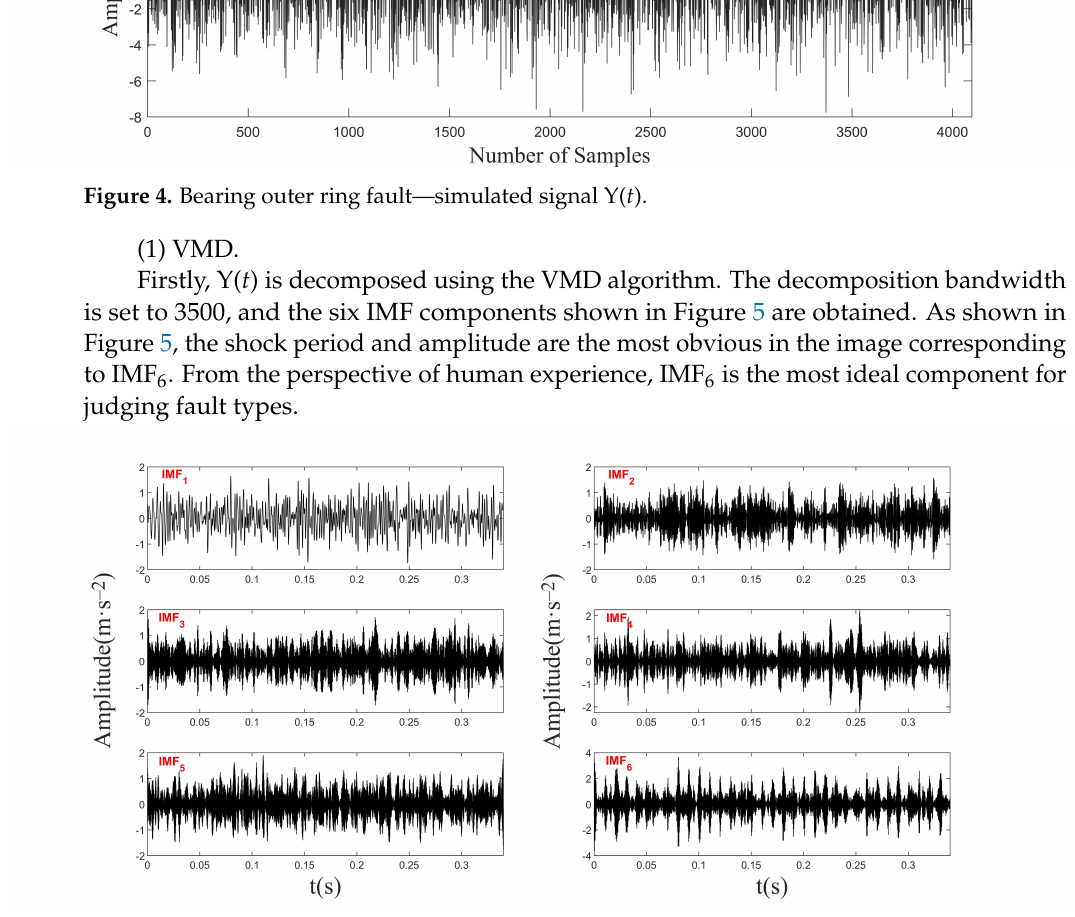
Figure 5. IMF decomposed from